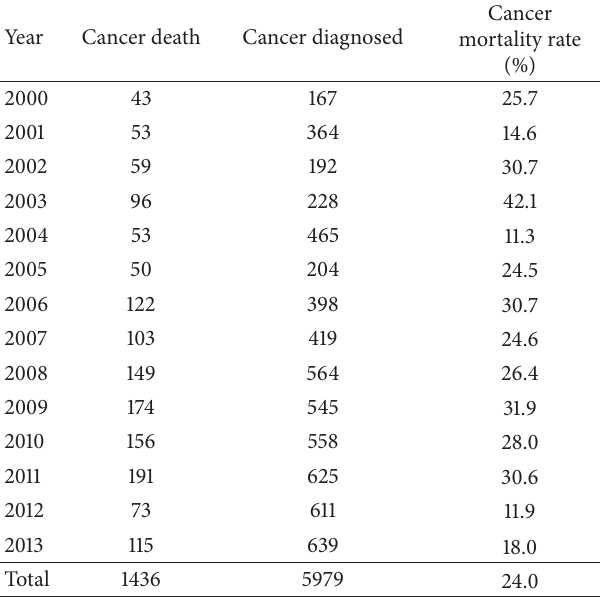
Table 4: Showing the yearly cancer mortality